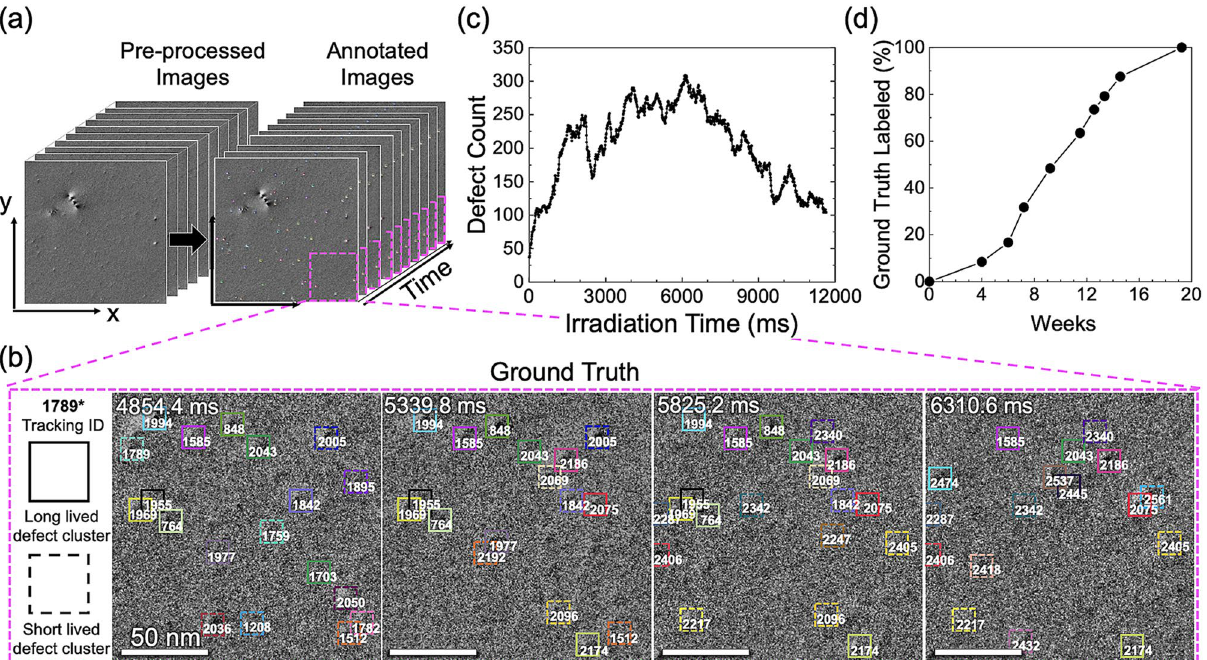
Figure 2. An overview of the ground truth annotation, defect count quantification, and labeling cost. ( a ) An in-situ irradiation TEM video of 1200 frames (9.7 ms/frame) was manually annotated. ( b ) Illustration of the annotation performed on example video frames. Both long-lived (solid lines) and short-lived (dashed lines) defects are shown with their unique tracking ID. Defect clusters with a lifetime longer than 980.5 ms are considered long-lived. ( c ) Defect count as a function of irradiation time quantified directly from the annotation. ( d ) Time spent on ground truth manual annotation and